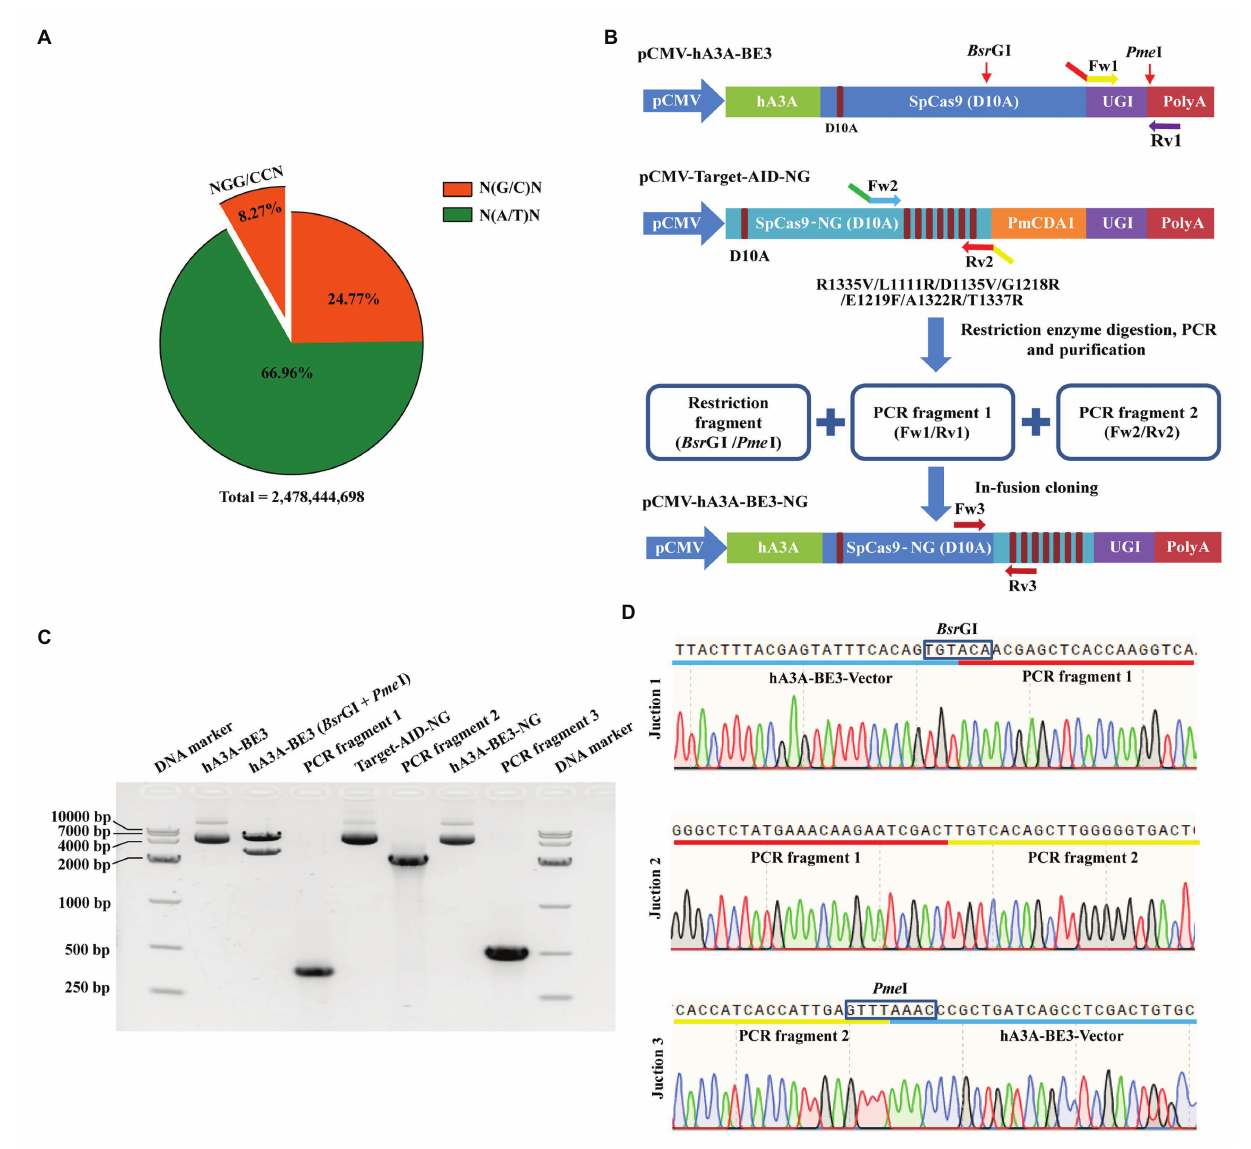
FIGURE 1 | Construction of hA3A-BE3-NG vector for expanded targeting scope. (A) Pie chart shows the proportion of porcine genomic sites that can be targeted by SpCas9 or SpCas9-NG with distinct protospacer adjacent motif (PAM) specificities (NGG or NG). Pig reference genome (Sscrofa11.1) was used for analysis. (B) Schematic of the pCMV-hA3A-BE3-NG vector. Compared to SpCas9 (D10A) in hA3A-BE3, SpCas9-NG (D10A) in Target-AID-NG contained seven amino acids variants: R1335V, L1111R, D1135V, G1218R, E1219F, A1322R, and T1337R. hA3A-BE3-NG was constructed by in-fusion cloning of a restriction fragment digested via Bsr GI and Pme I from hA3A-BE3, PCR fragment 1 amplified from hA3A-BE3 via Fw1/Rv1 primers, and PCR fragment 2 amplified from Target-AID-NG via Fw2/ Rv2 primers. Overlapping sequences exist in the junction of the three different fragments. (C) The gel image indicates that hA3A-BE3 was digested into two fragments by Bsr GI and Pme I. The PCR fragment 1 (387 bp) was amplified from hA3A-BE3 via Fw1/Rv1 primers, and the PCR fragment 2 (2,556 bp) was amplified from Target-AID-NG via Fw2/Rv2 primers. The large fragment (5,570 bp) from hA3A-BE3, PCR fragment 1 and PCR fragment 2 were fused into a recombinant vector, hA3A-BE3-NG, which was confirmed by a PCR product (540 bp) amplified via Fw3/Rv3 primers. (D) The chromatograms of Sanger sequencing show the junctional sequence was accurate among the above three fragments in recombinant